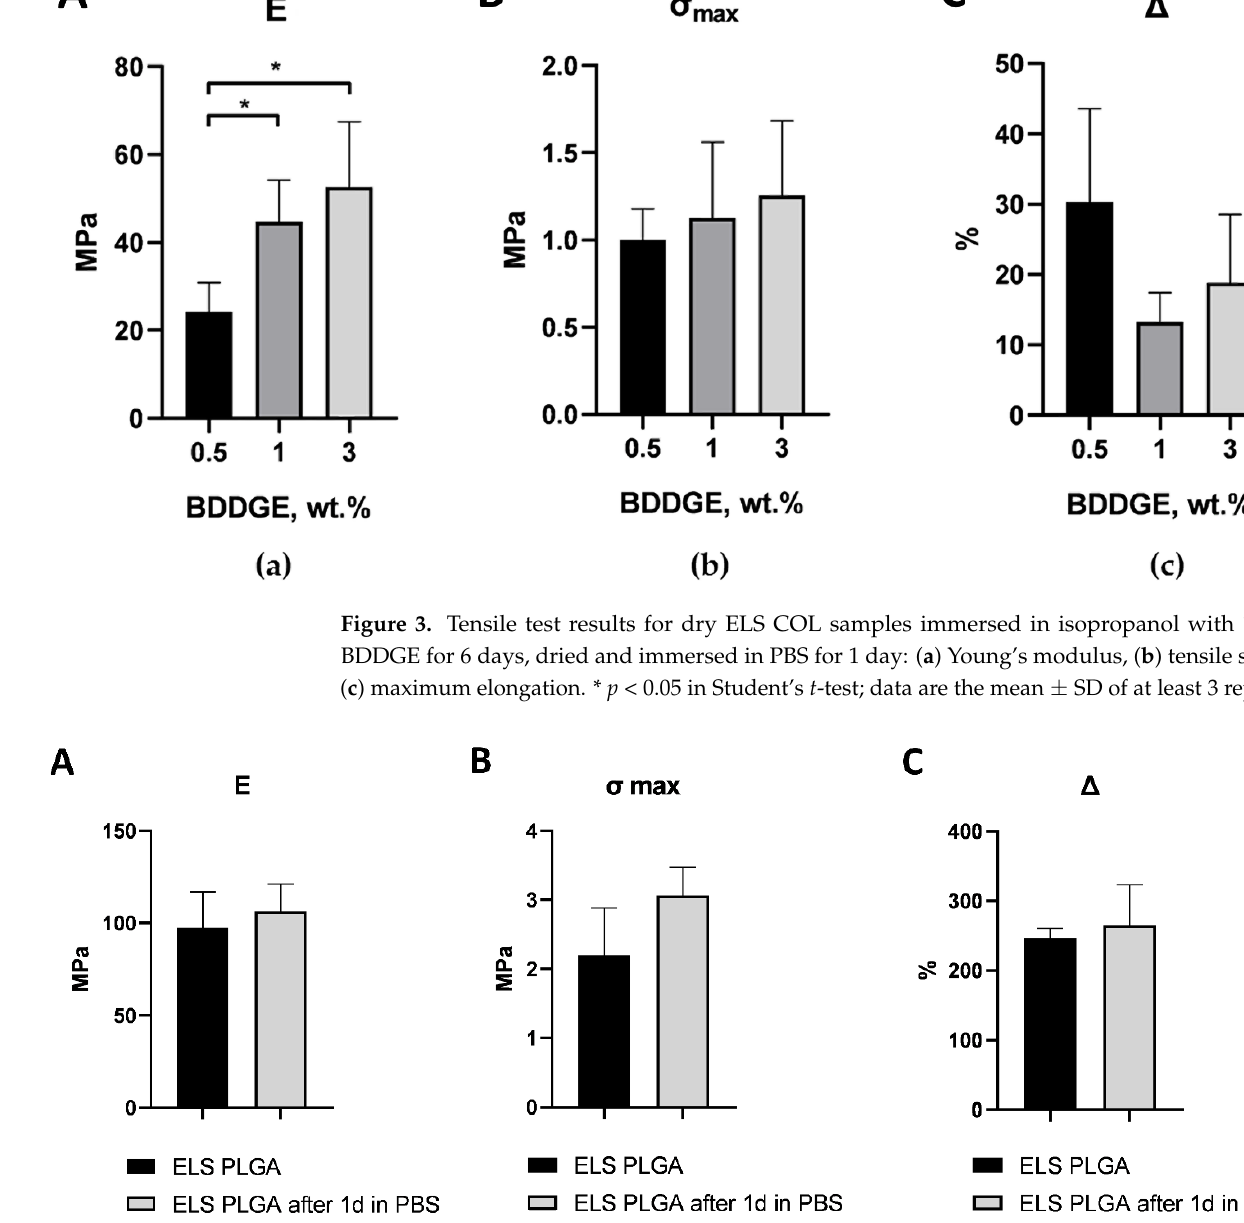
Figure 4. Tensile test results for ELS PLGA samples dried and immersed in PBS for 1 day: ( a ) Young’s modulus, ( b ) tensile strength, ( c ) maximum elongation; data are the mean ± SD of at least 3 replicates.